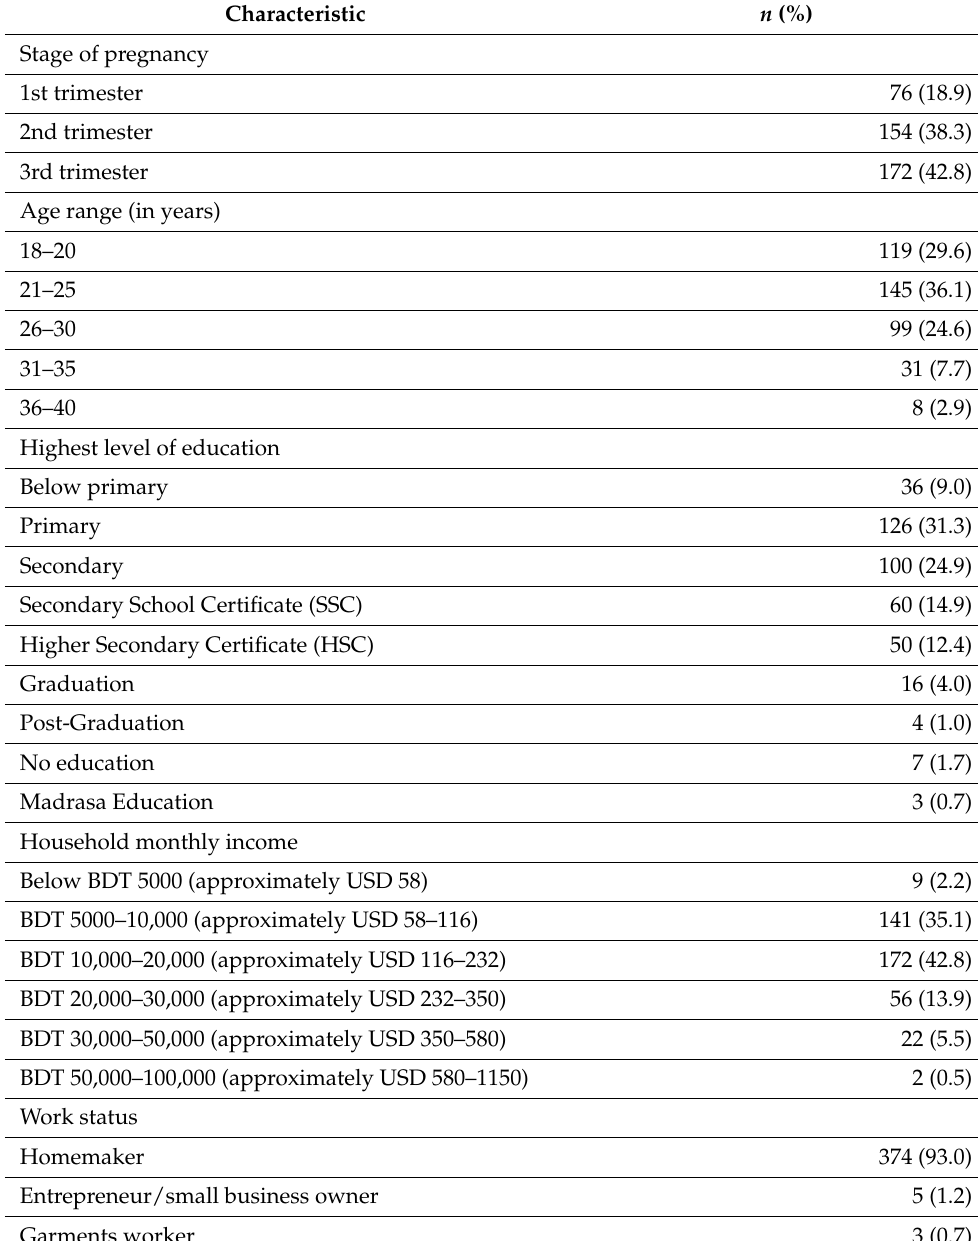
Table 2. Pregnant women participant